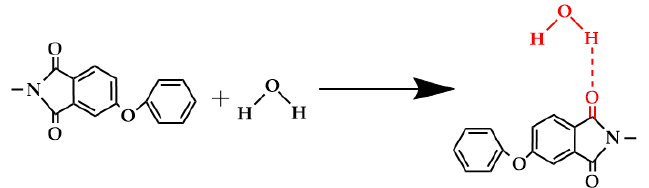
Figure 11. Hydrogen bonding between carbonyl groups and water molecules .